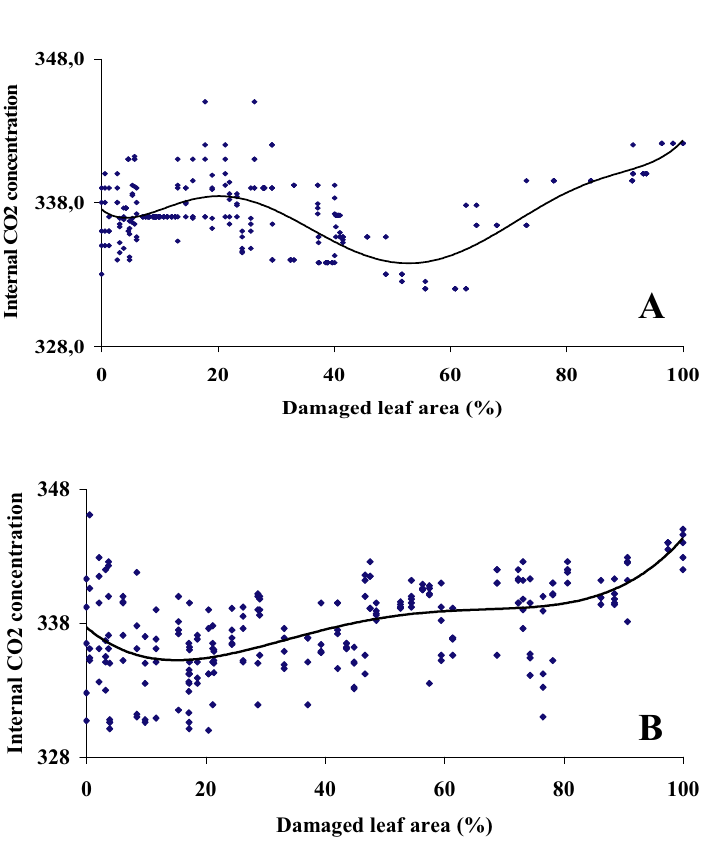
Fig. 7 – Effect of leaf area damaged (0 to 100%) by O. praelonga (A) and L. coffeella (B) on the internal concentration of CO 2 (mmol/mol) in rangpur lime and Obatã coffee leaves,